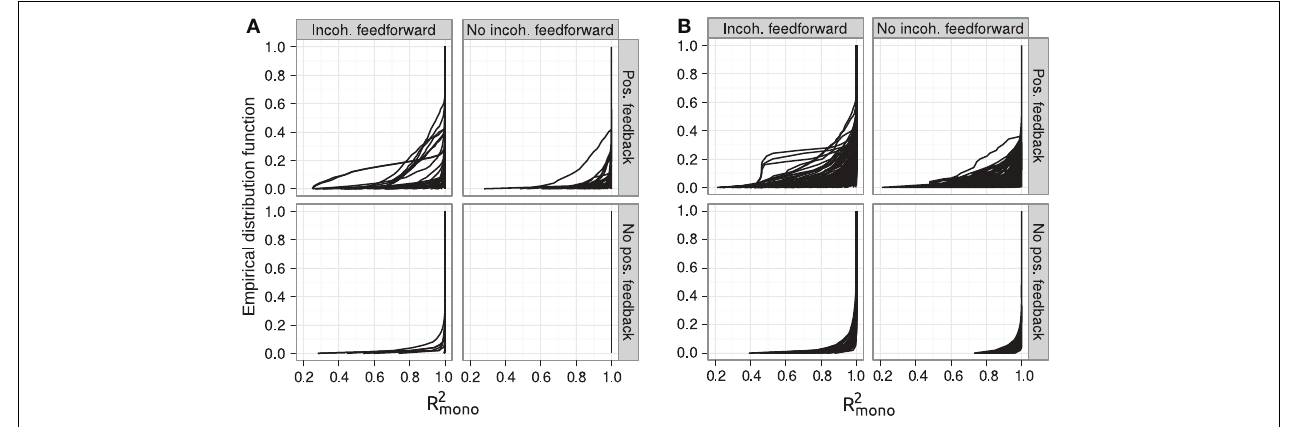
FIGURE 6 | Empirical distribution functions for R 2 mono . Summary of R 2 mono values from isotone regression for all motifs for which at least 100 (out of 1000) Monte Carlo simulations lead to GP maps with non-negligible phenotypic variation (see Models and Methods section “Gene regulatory network simulations,” for detailed criteria). Results are shown for 1013 motifs with a genotype-to-parameter map without